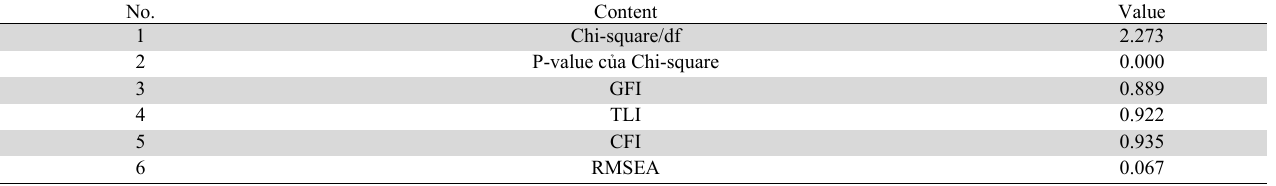
CFA analysis results according to standardized coefficients